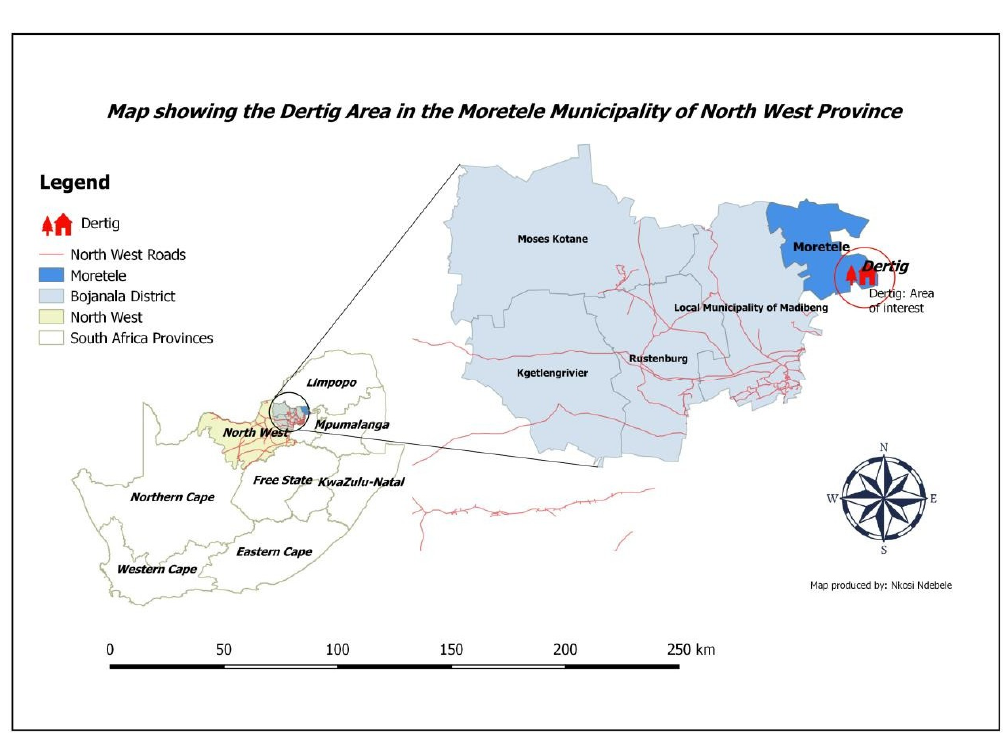
Figure 1. Study area: South Africa.